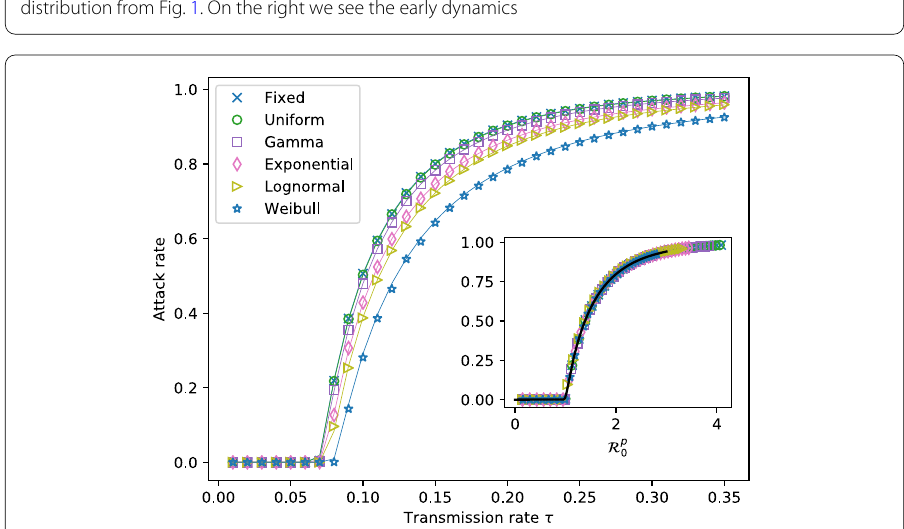
Figure 3 Epidemic sizes in an Erd˝os–Rényi network. We look at epidemics in an Erd˝os–Rényi network with 10 6 nodes and average degree 10. The results are similar to Fig. 1. Using the heterogeneous R p 0 all curves collapse on a universal curve. The parameters, mean and variance of the distributions are given in Table